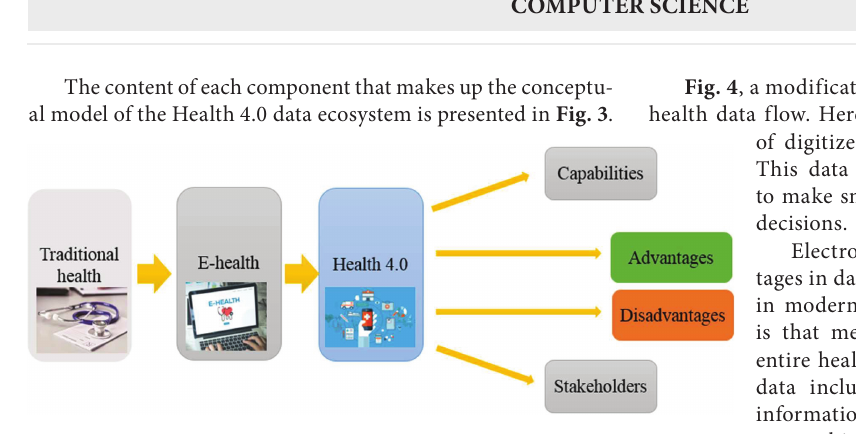
Fig. 2 . A conceptual model of the healthcare 4.0 data ecosystem formation chain